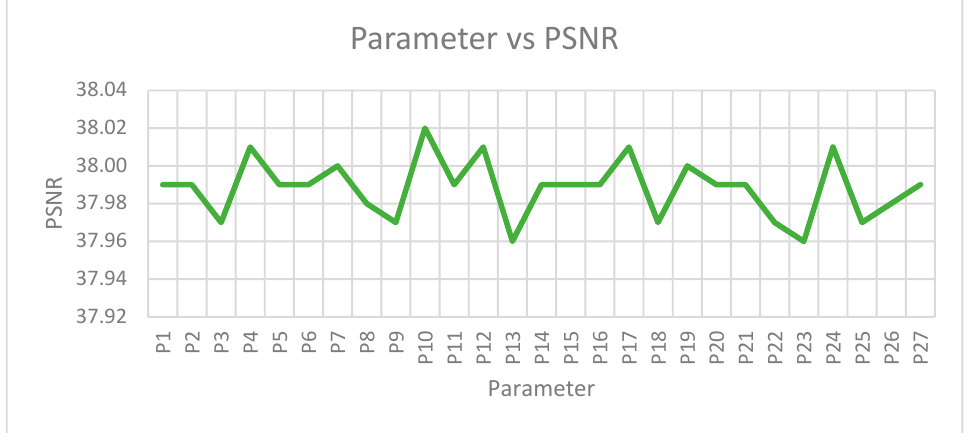
Figure 5. The impact of parameter set towards PSNR for image upscaling with factor four. Table 6. The impact of parameter values on PSNR values.